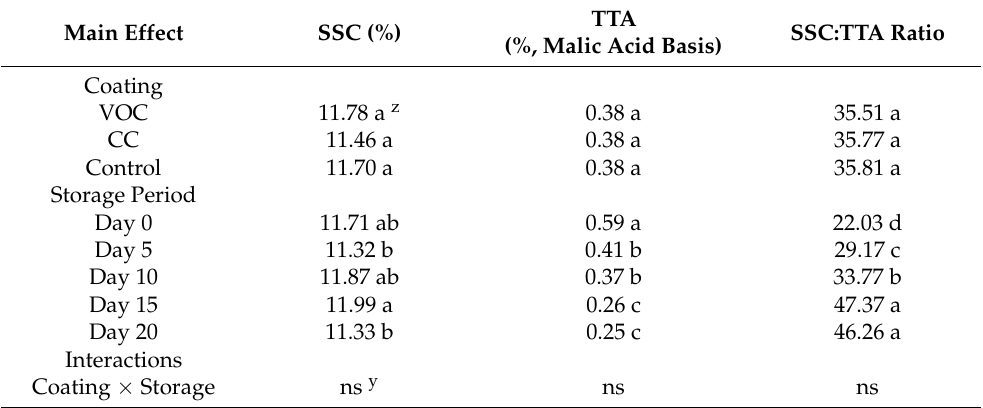
Table 3. Main effects and interactions for composition of mesocarp tissue from coated and uncoated pitaya fruit after 20 days storage at 7 ◦ C.